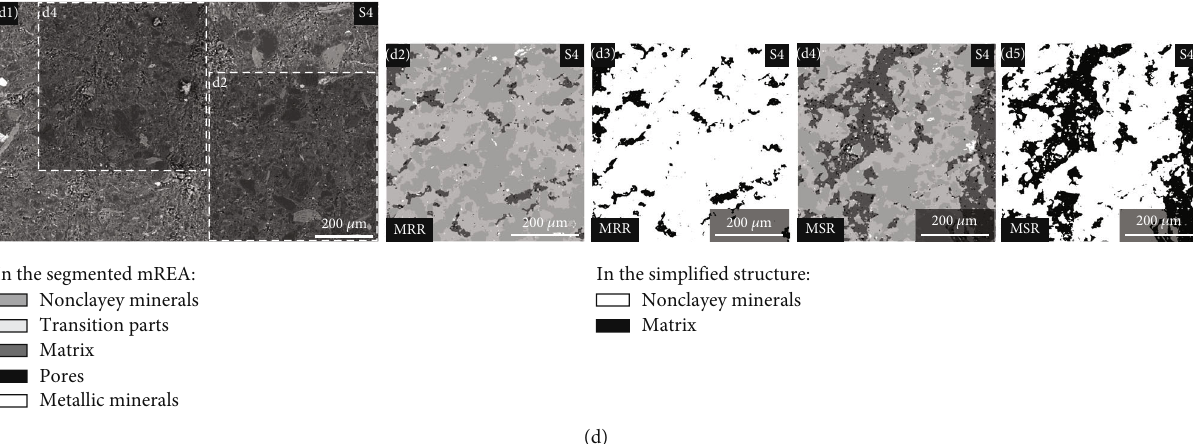
Figure 2: Backscattered electron image, MRR, MSR, and simpli fi ed structures of four red mudstone samples. (a), (b), (c), and (d) represent samples S1-S4, respectively. In each row, labels 1-5 represent the stitched BSE image, the segmented MRR image, the simpli fi ed MRR for simulations, the segmented MRR image, and the simpli fi ed MRR for simulations. The MRR and MSR are highlighted in the stitched BSE image.